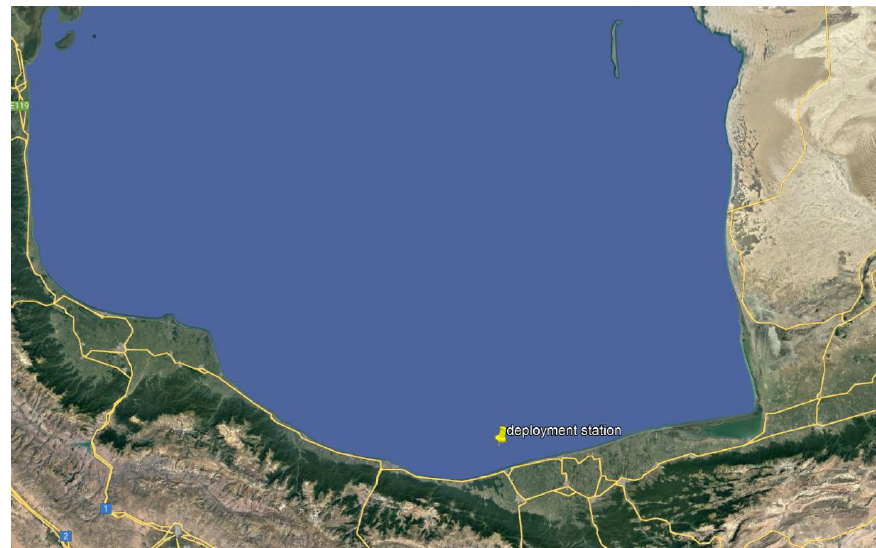
Figure 1. The area of study in the southern Caspian Sea coastal area (Muhmudabad).